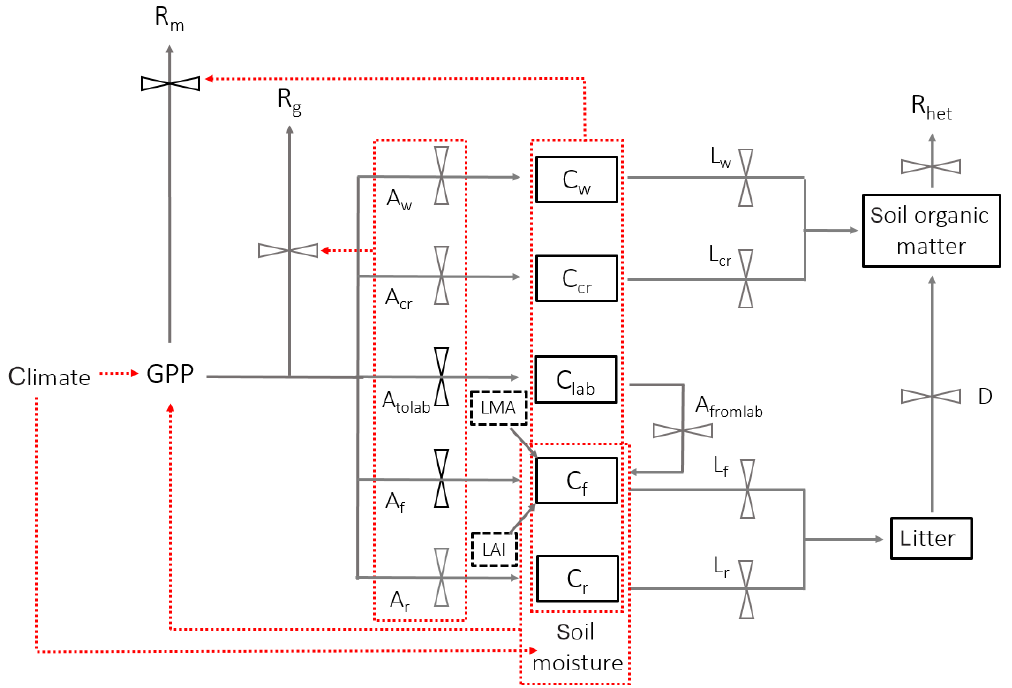
Figure 2. A schematic of DALEC canopy , the carbon allocation sub-model integrated within the soil–plant–atmosphere model. Carbon moves between pools (solid boxes) via fluxes (solid arrows). Leaf carbon fluxes are constrained by field measurements (black dashed boxes). An effect of climate, carbon pools or fluxes on another carbon flux is shown by a red dashed arrow, whereby red dotted boxes indicate a collective impact of the contained carbon pools or fluxes. Black flux bars indicate that the carbon pathway is prioritised within the model above pathways from the same node. Climate is a model input, and soil moisture is simulated within SPA. Carbon pools (C), allocation (A) and litterfall (L) are separated by component: w represents wood, cr represents coarse roots, r represents fine roots, f represents foliage, and lab represents labile (or non-structural carbon), with to and from used for labile